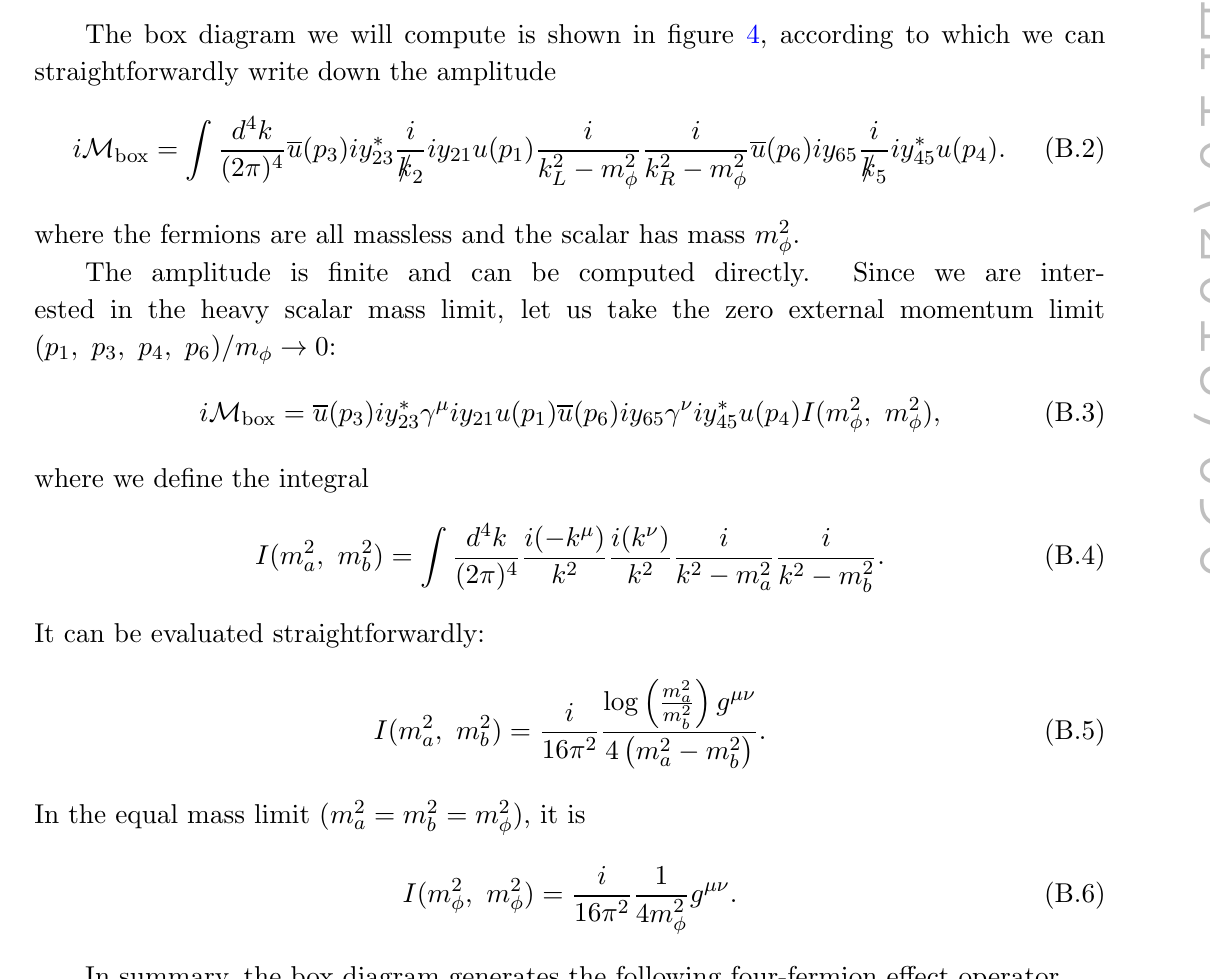
(cid:13) (cid:22) 1 (cid:13) (cid:22) 4 3 6